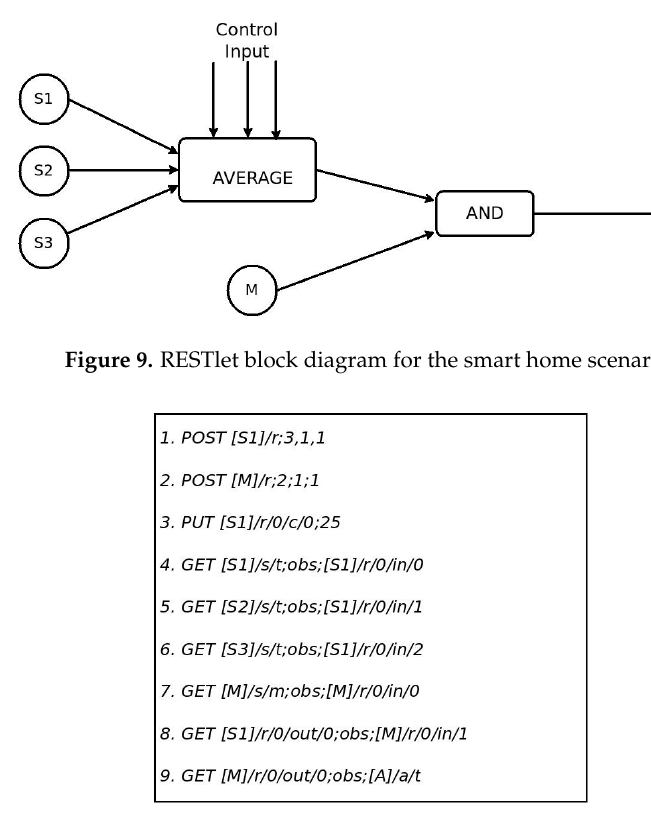
Figure 10. CoAP Messages used to create the required Binding Relationship.